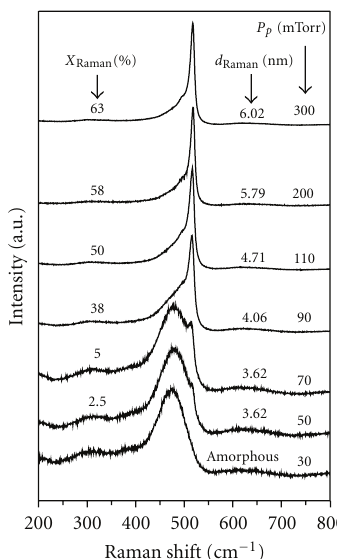
Figure 4: Raman spectra of Si:H films deposited by hot wire method at various process